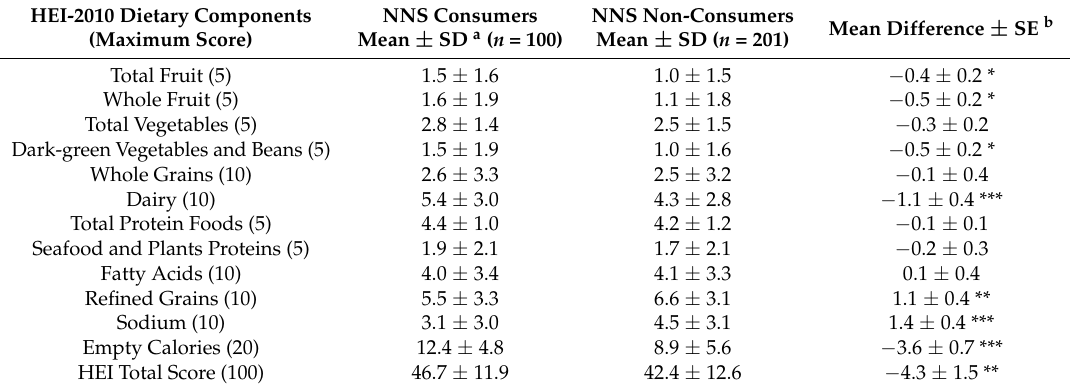
Table 6. Dietary quality (Healthy Eating Index (HEI-2010)) for non-nutritive sweetener (NNS) consumers versus NNS non-consumers.